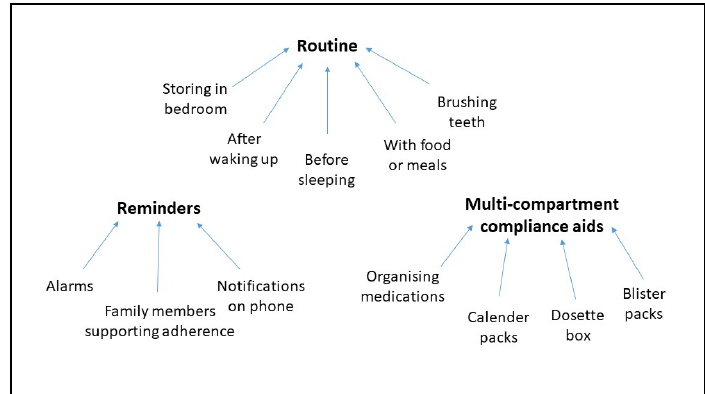
Figure 1. Strategies used by participants to reduce